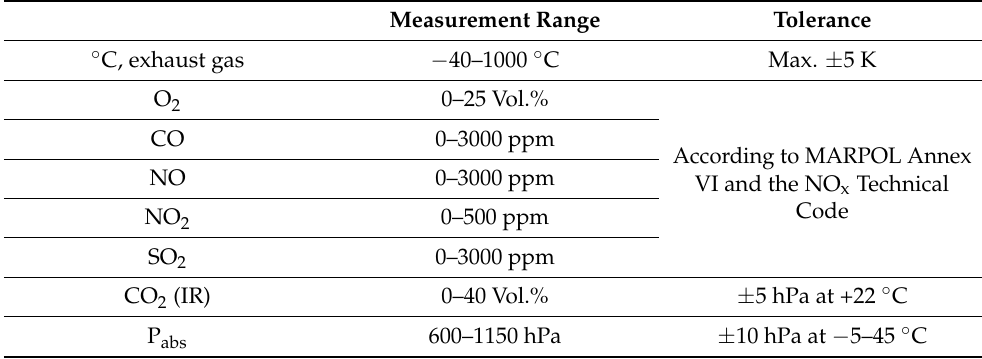
Table 5. Measuring device technical